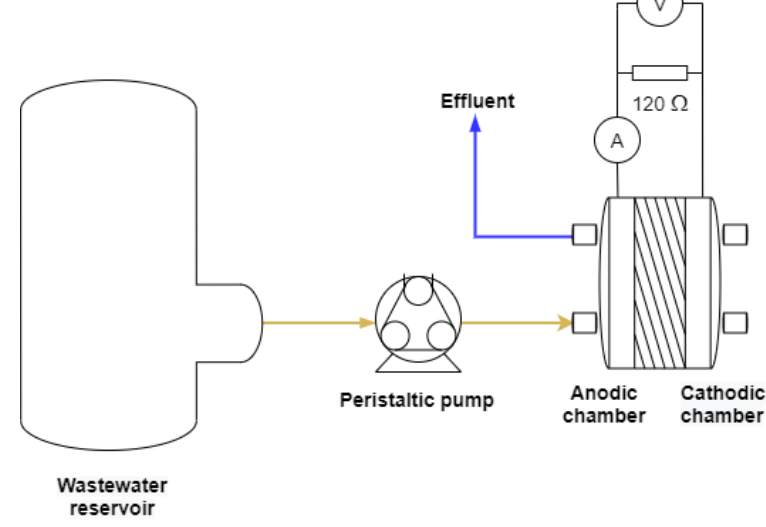
Figure 1. Schematic view of the experimental setup.